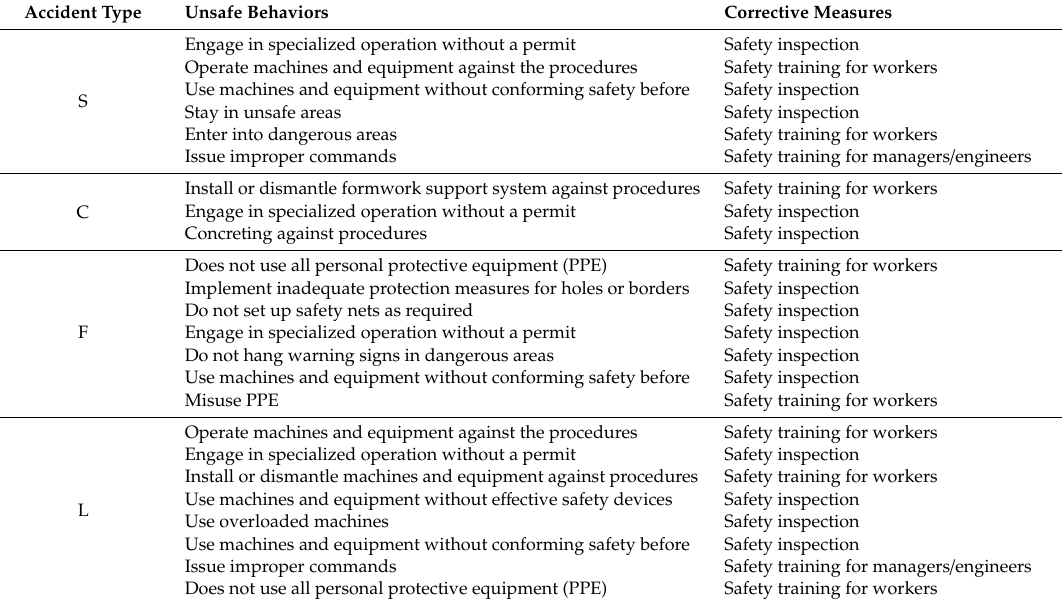
Table 5. Corrective measures for the unsafe behaviors in the four